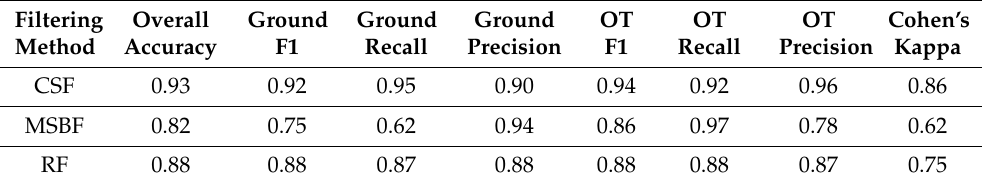
Table 2. Accuracy metrics for all filtering methods on the full testing dataset.